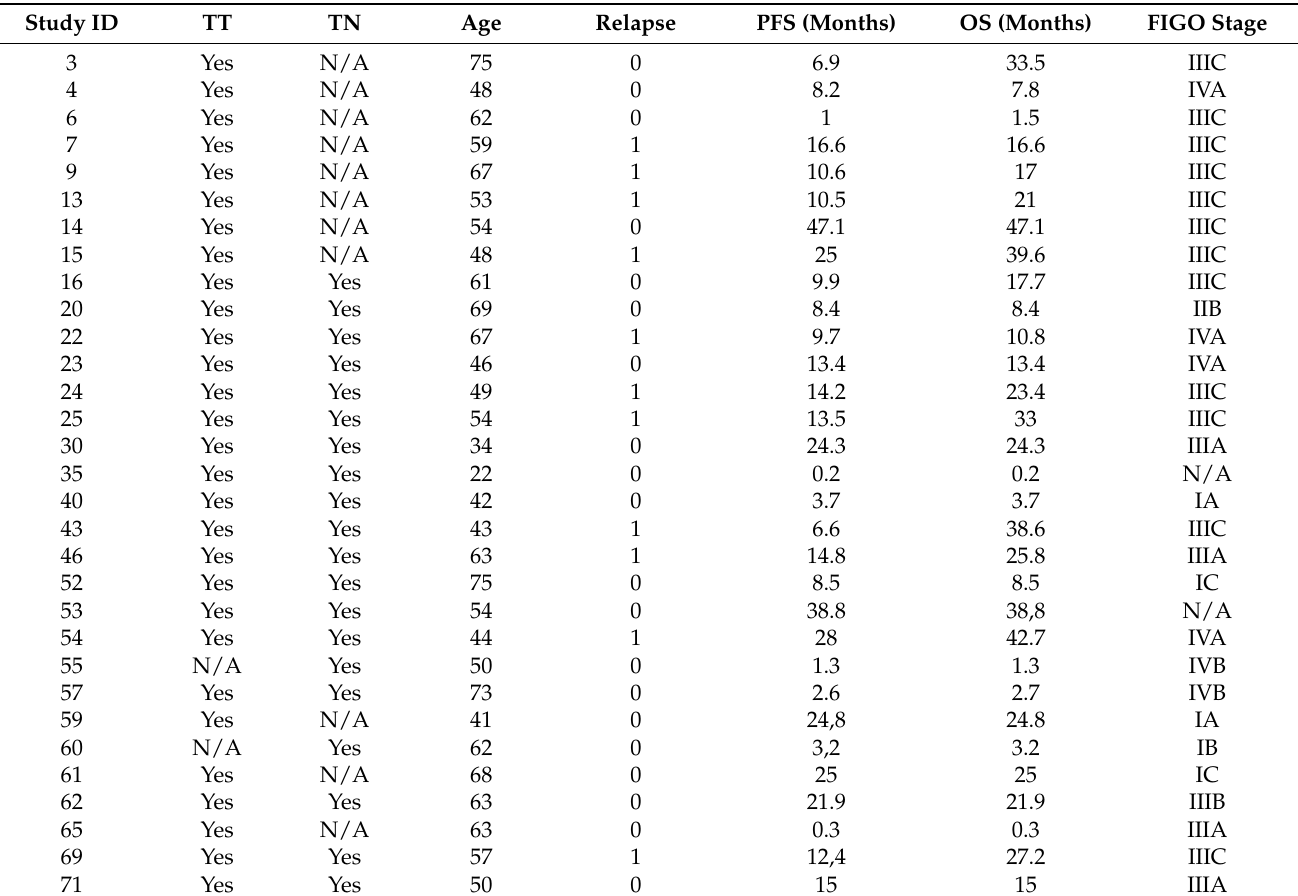
Table 1. Clinical data of ovarian cancer (OC)